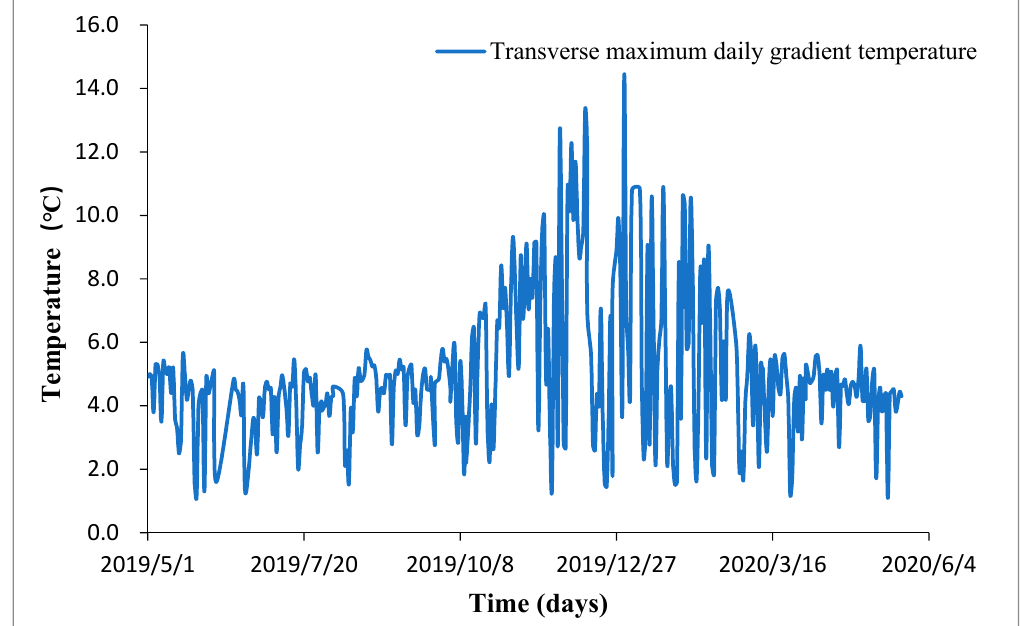
Figure 8. Maximum daily positive lateral temperature gradient variations.